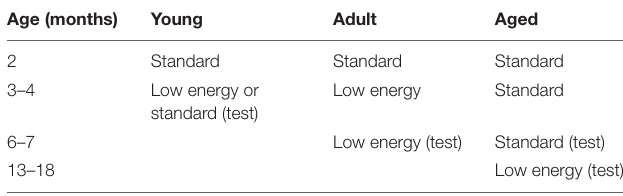
TABLE 1 | Timetable of the different feeding